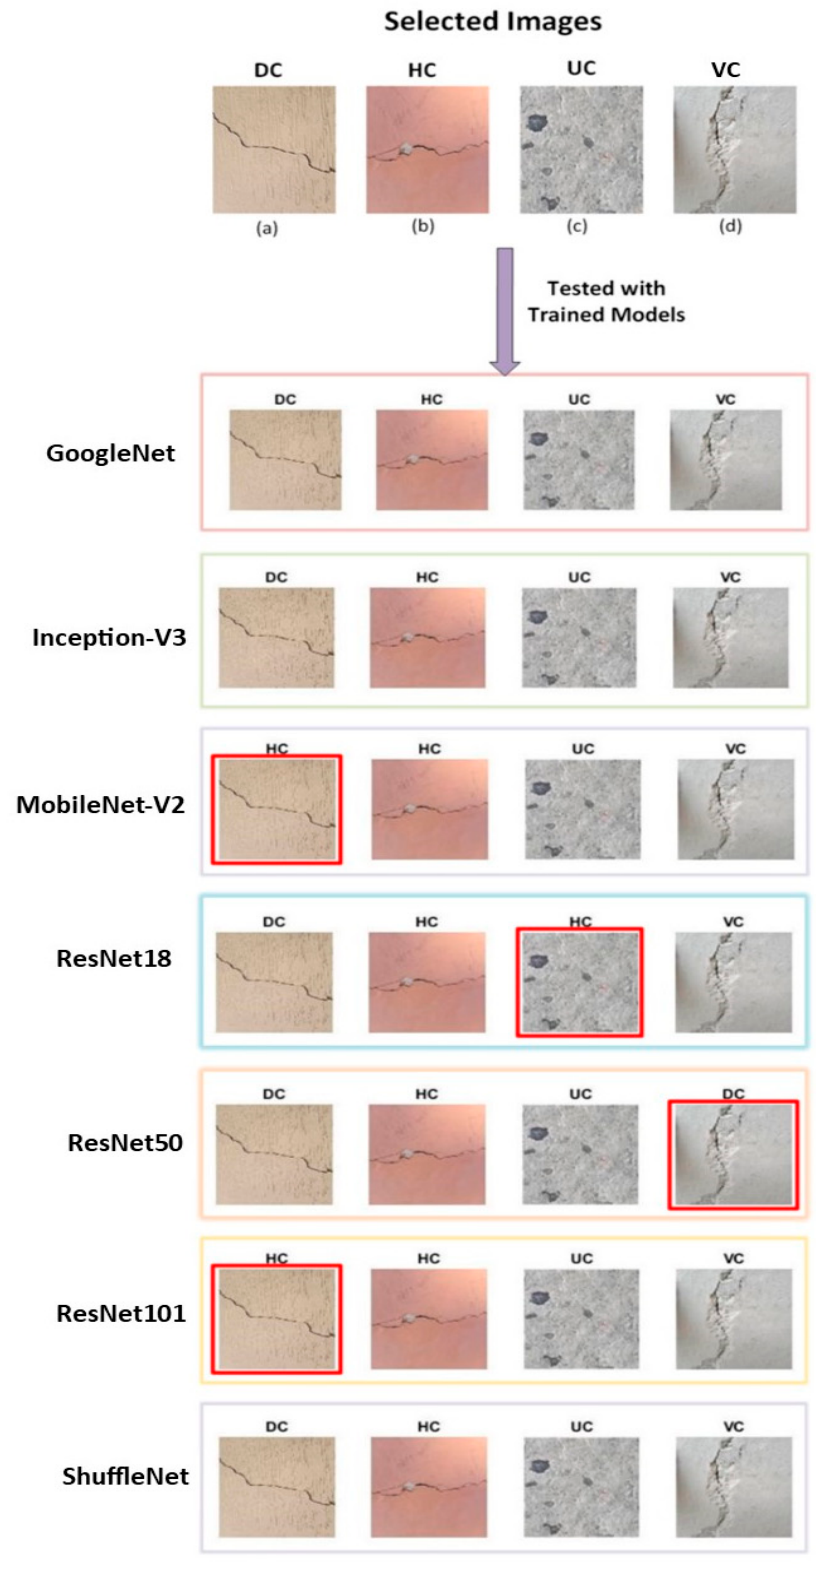
Figure 6. Selected images and results after passing through trained models, while red boxes show poor predictions against each model.